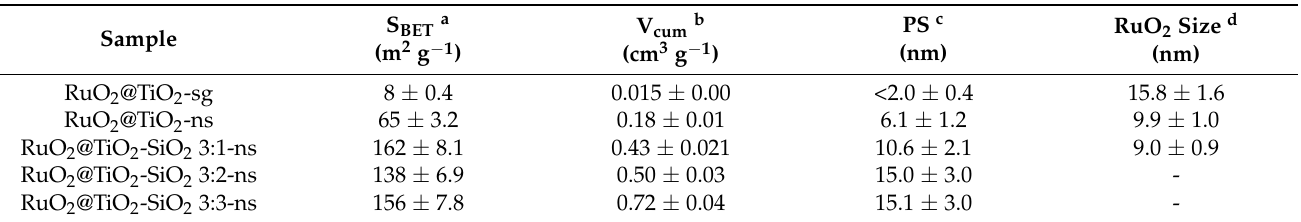
Table 2. Characteristics of supported RuO 2 @TiO 2 and RuO 2 @TiO 2 -SiO 2 catalysts after thermal treatment at 400 ◦ C.